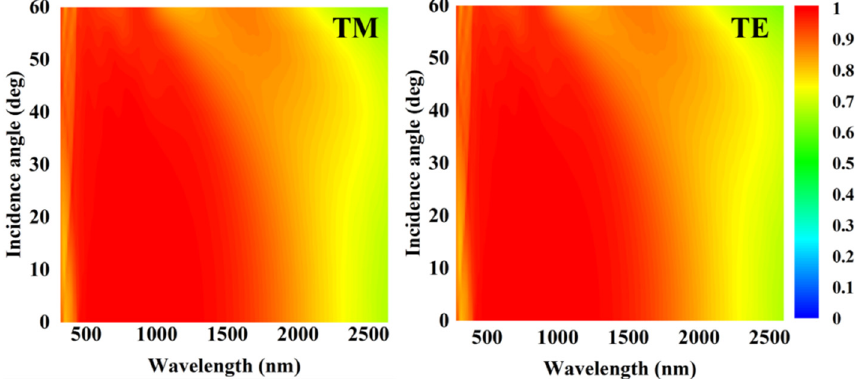
Figure 13. Absorption spectra of oblique incident angle for TM and TE modes, respectively.